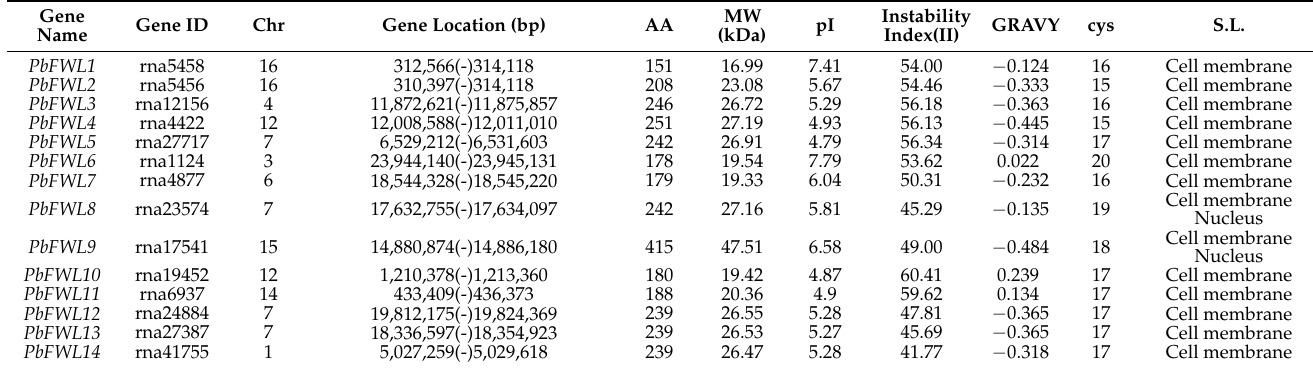
Table 1. Sequence characteristics of 14 genes identified in